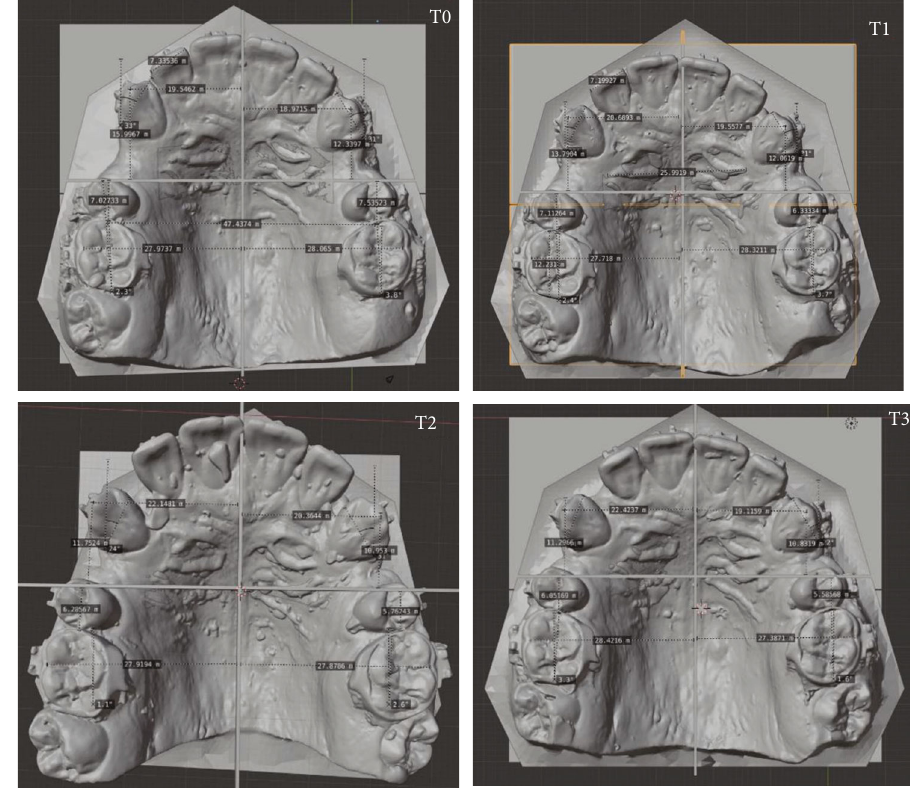
Figure 3: Digitized dental cast from T0 to T4. Table 2: Periodontal diagnosis at study